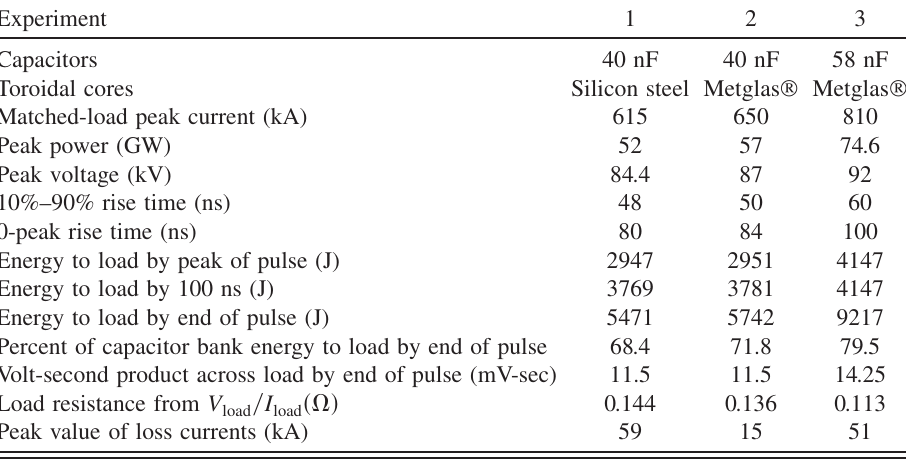
TABLE I. Summary of results for LTD-III shots into matched loads with capacitors charged to (cid:4) 100 kV .